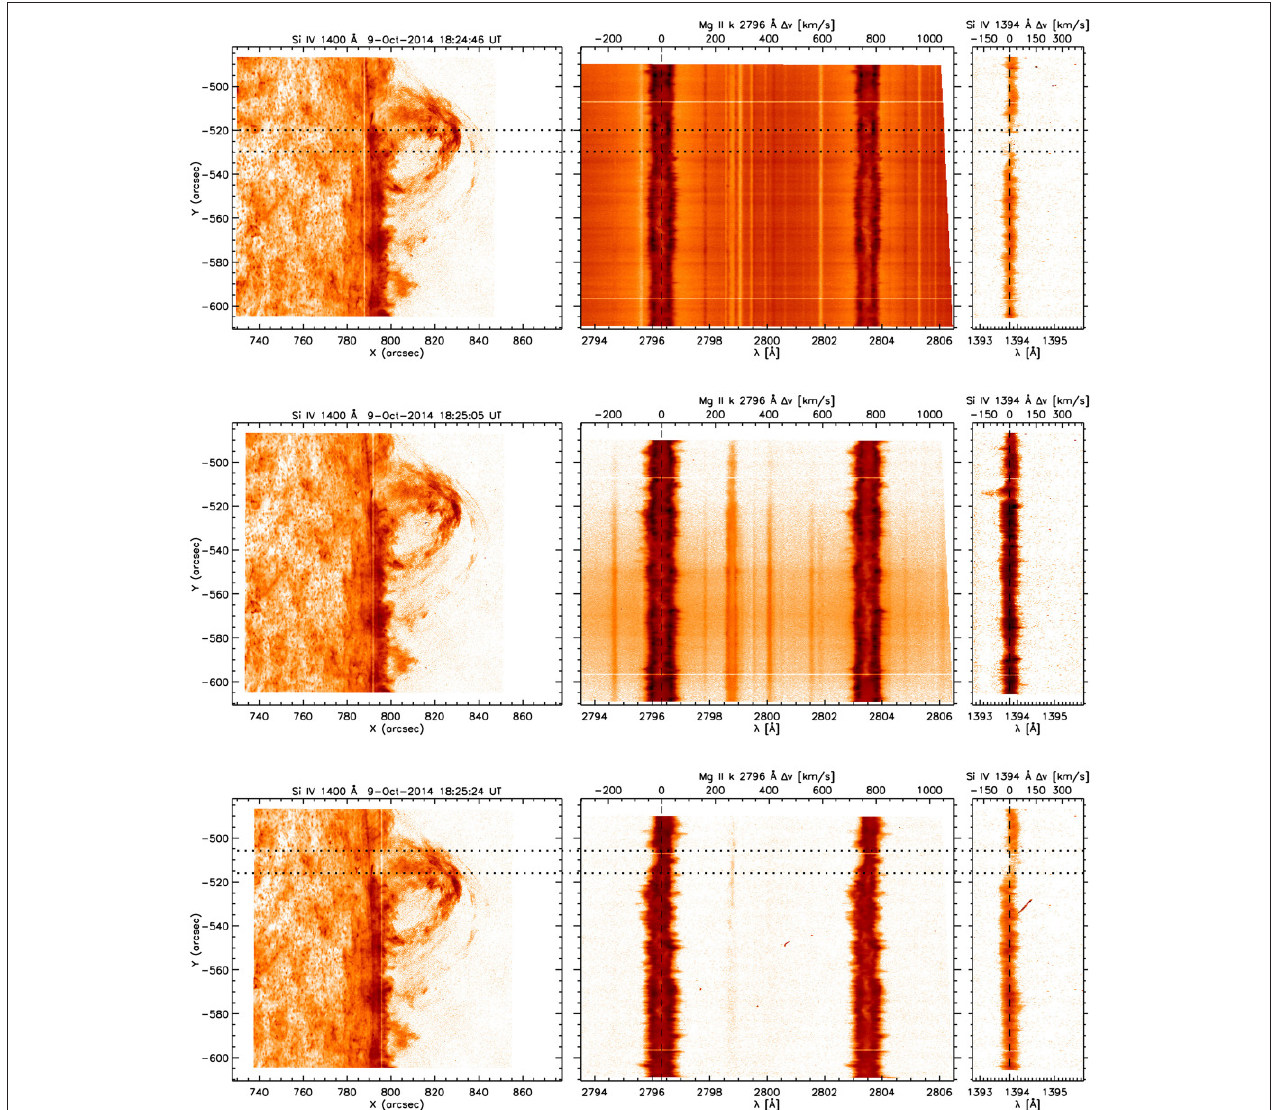
FIGURE 10 | Left: IRIS Si IV 1400 Å with corresponding spectra for the Mg II 2796 Å (middle) and Si IV 1394 Å (right) . The vertical dashed lines represent the rest wavelength. The horizontal dotted lines outline a region of decreased Si IV 1394 Å line intensity in the right image.